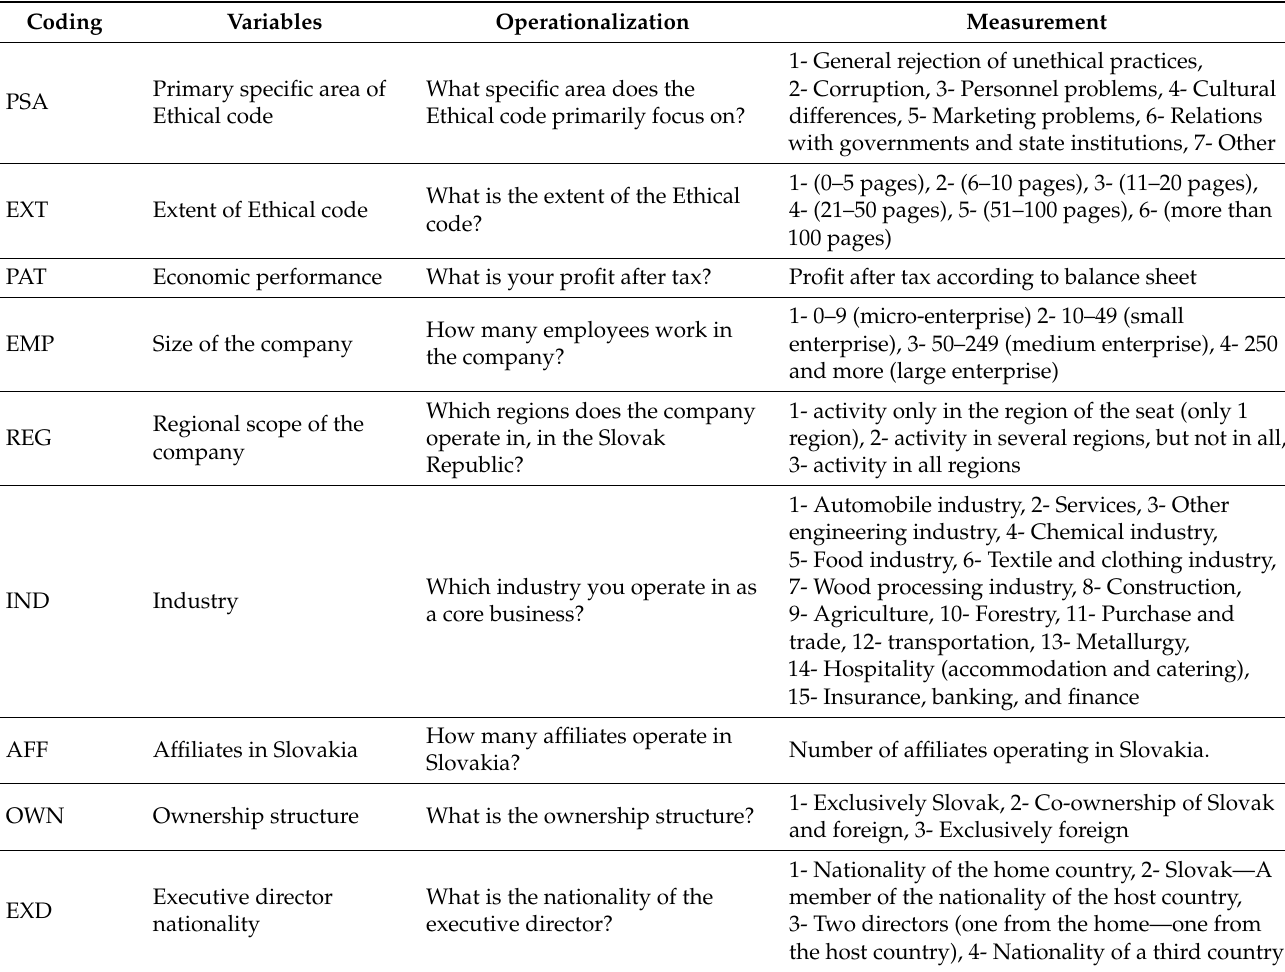
Table 1. Design of questionnaire: operationalization of